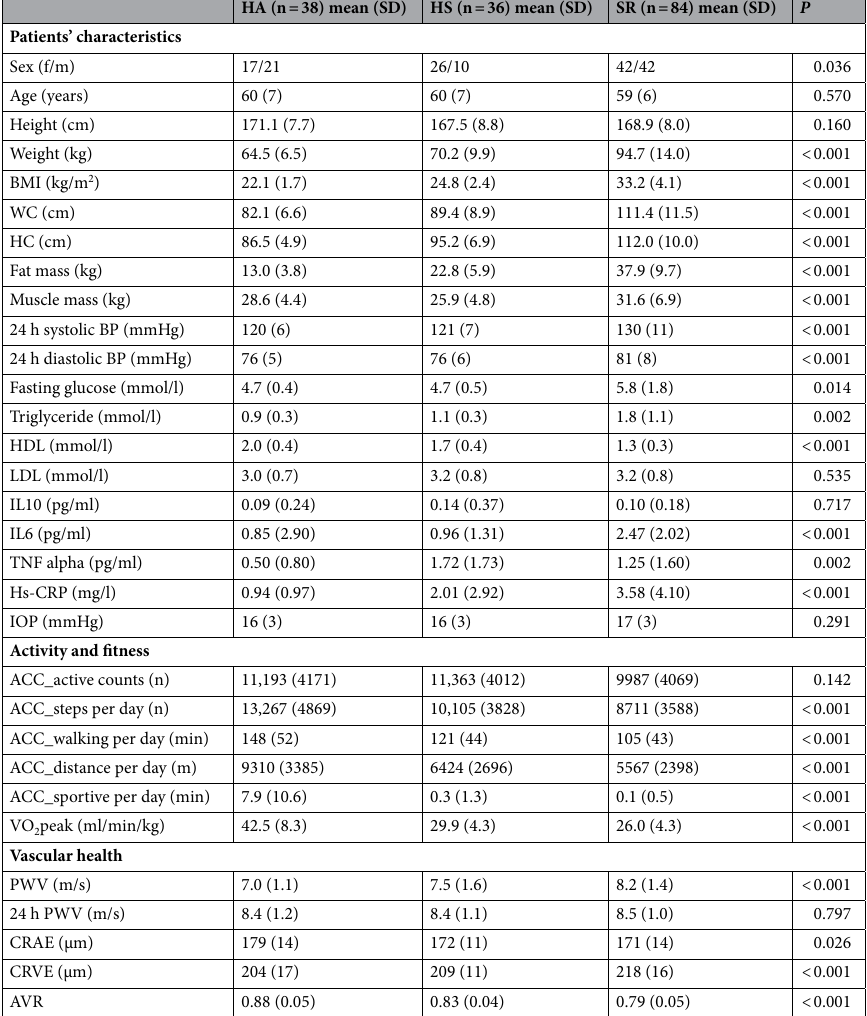
Table 1. Sample characteristics. HA healthy active, HS healthy sedentary, SR sedentary at risk, SD standard deviation, p ANOVA level of significance for overall group differences, BMI body mass index, WC waist circumference, HC hip circumference, BP blood pressure, HDL high-density lipoprotein, LDL low-density lipoprotein, IL interleukin, TNF tumor necrosis factor, Hs-CRP high sensitive C-reactive protein, IOP intraocular pressure, FQPA Freiburg questionnaire of physical activity, METs metabolic equivalents, ACC accelerometer, VO2peak peak oxygen uptake, PWV pulse wave velocity, CRAE central retinal arteriolar equivalent, CRVE central retinal venular equivalent, AVR arteriolar-to-venular diameter